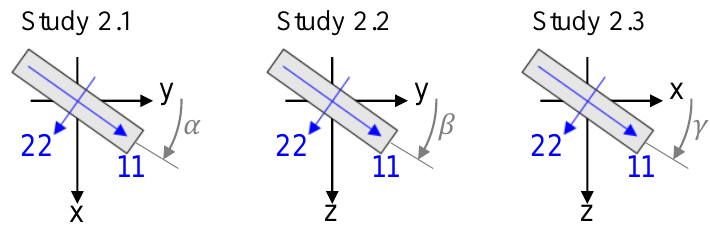
Figure 4. Visualization of the fiber orientations in study